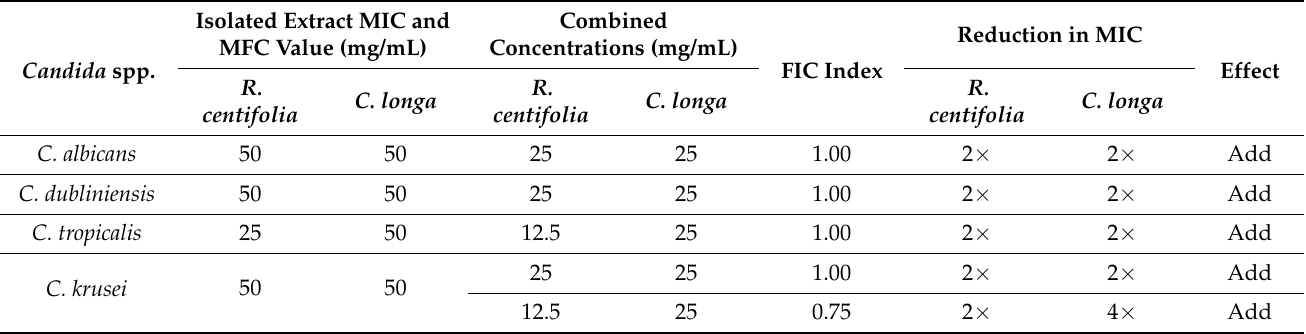
Table 5. Minimum inhibitory concentration (MIC) and minimum fungicidal concentration (MFC) values in mg/mL, in addition to the combined effect of R. centifolia and C. longa glycolic extracts, against Candida spp.